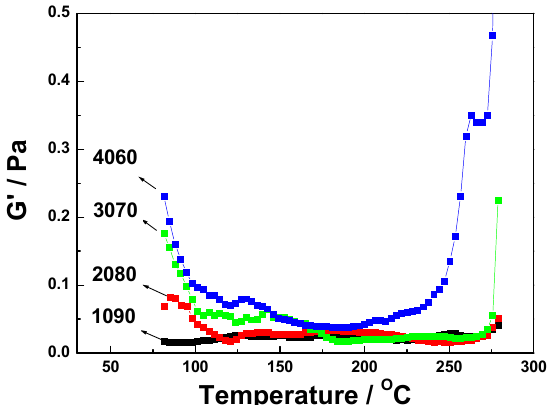
Figure 4. Shear storage modulus (G’) as a function of temperature curves for 1090, 2080, 3070, and 4060 resins.